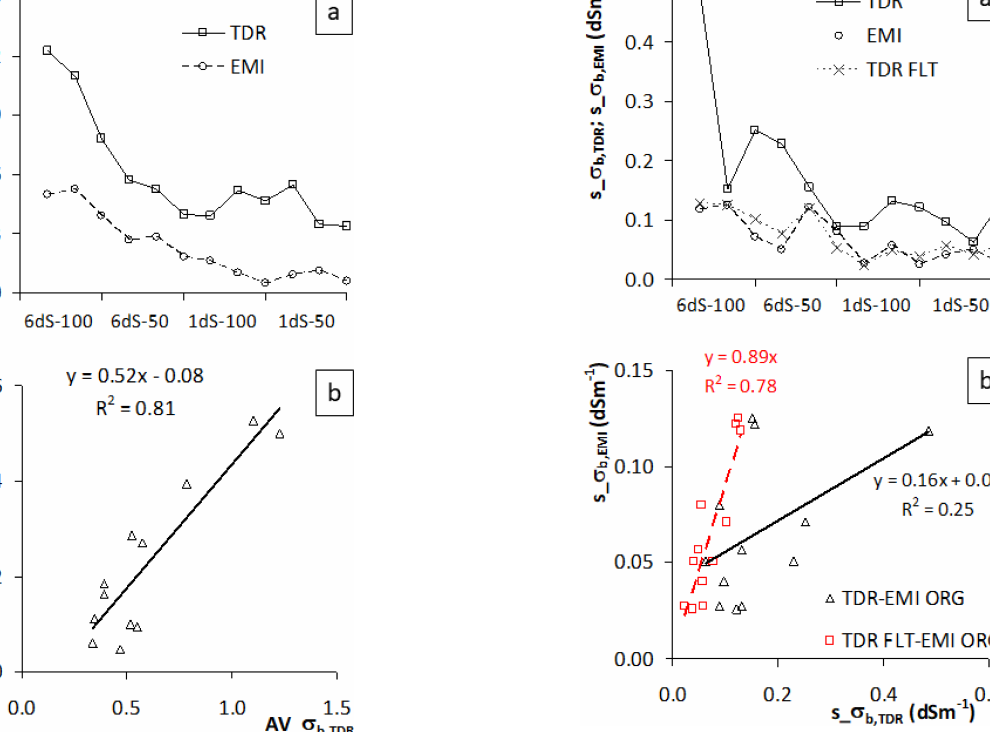
Figure 8. (a) Comparison of the means for the two original series (squares and solid line for TDR, circles and dashed line for EMI) and (b) the same comparison on a 1:1 plot (triangles and solid re- gression line). In (a) , the four cases are shown in sequence. For each case, the three values are for the three depth intervals 0.0–0.2, 0.2– 0.4 and 0.4–0.6m.